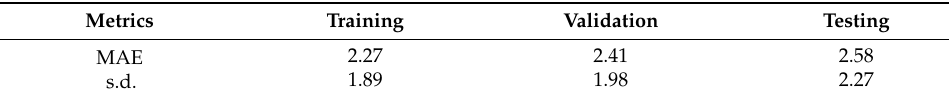
Table 3. MAE with s.d. for training, validation and